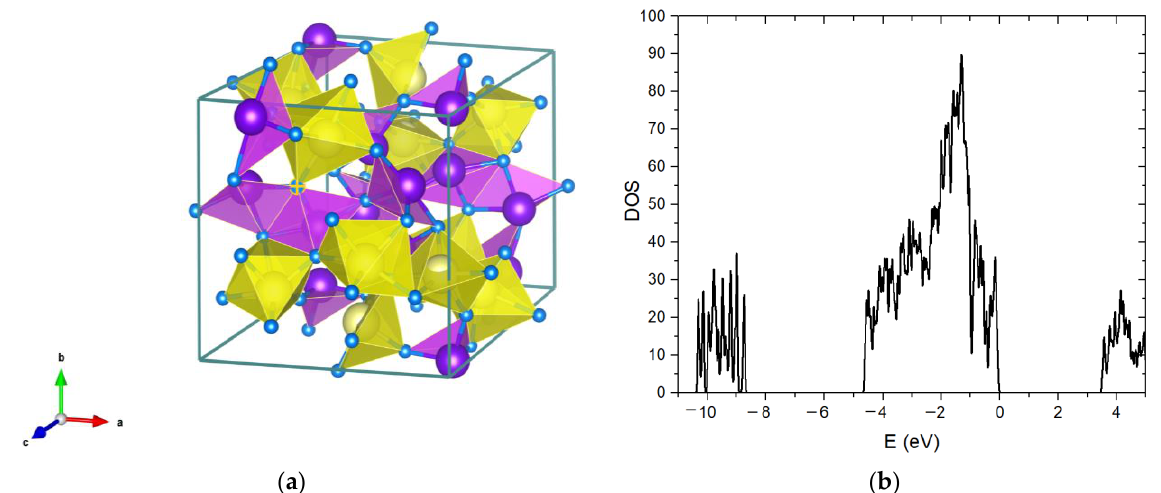
Figure 5. ( a ) Structure of Ca 2 Bi 2 O 5 visualizations; ( b ) Total density of states calculated with HSE06 functional.